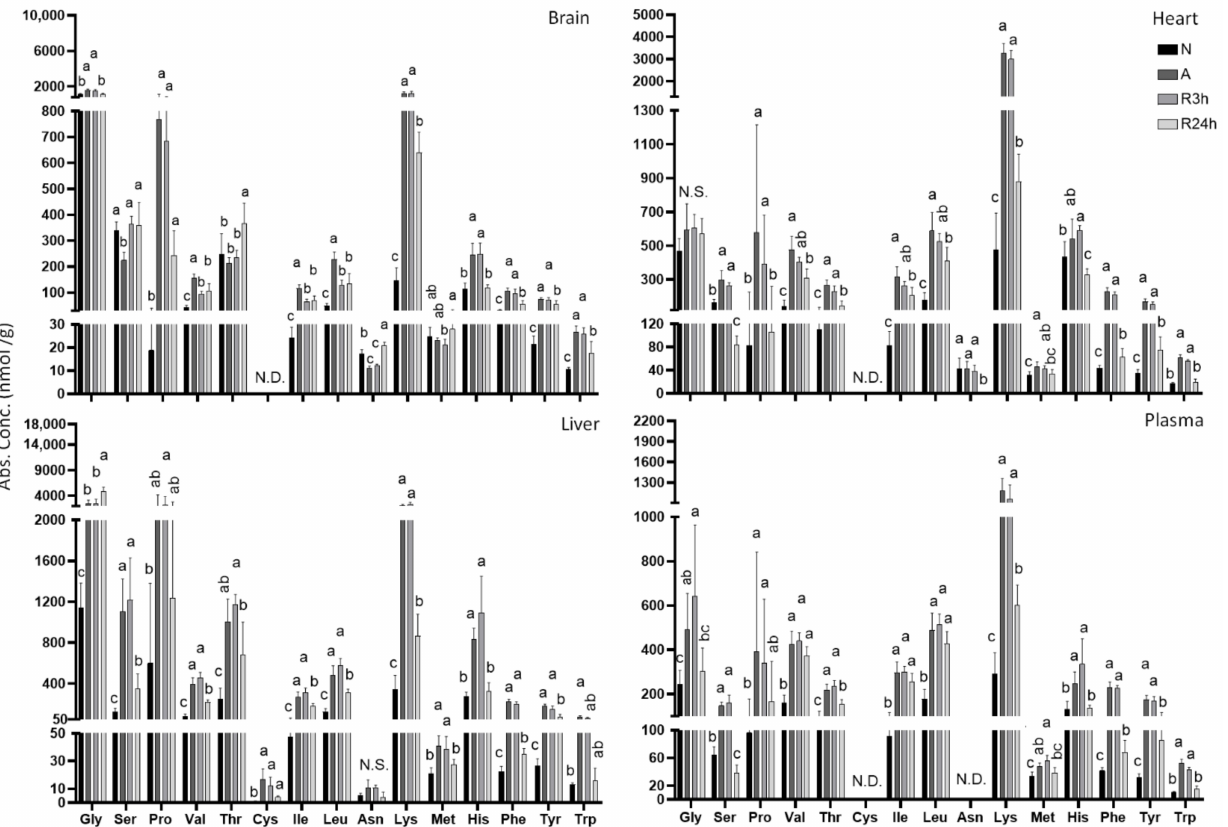
Figure A3. Amino acids. Graphs of absolute concentrations for amino acids of brain, heart, liver, and blood plasma, excluding the amino acids in Figure 10. N, normoxia (control); A, anoxia; R3h, 3 h reoxygenation; R24h, 24 h reoxygenation. Different letters indicate statistical differences between groups calculated using one-way ANOVA with Tukey’s post-hoc ( p -value ≤ 0.05). Data are presented as means ± S.D. Values as reported by